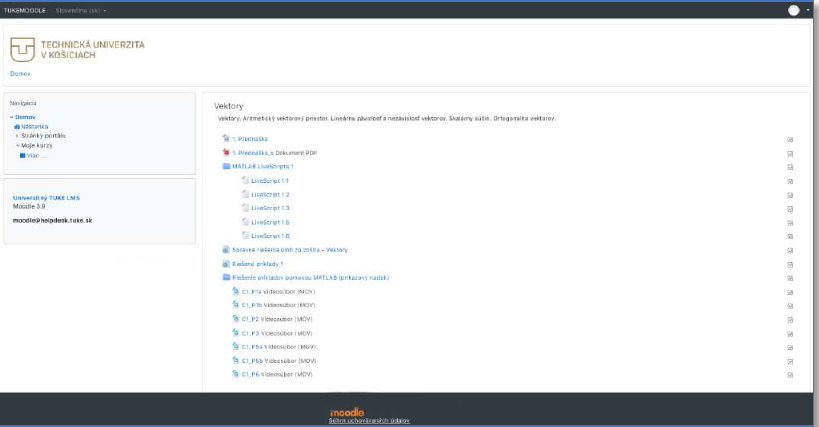
Figure 2. Representation of the created (split) modules in Moodle LMS.